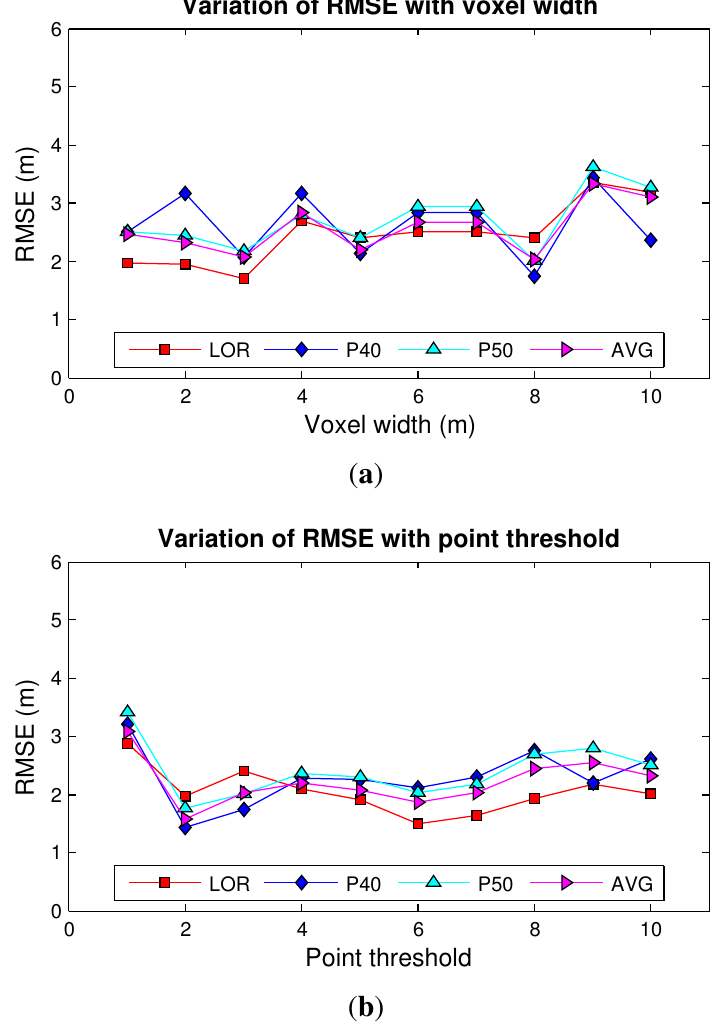
Figure 13. The effect of voxel width ( a ) and point threshold ( b ) on the model RMSE on the four dependent